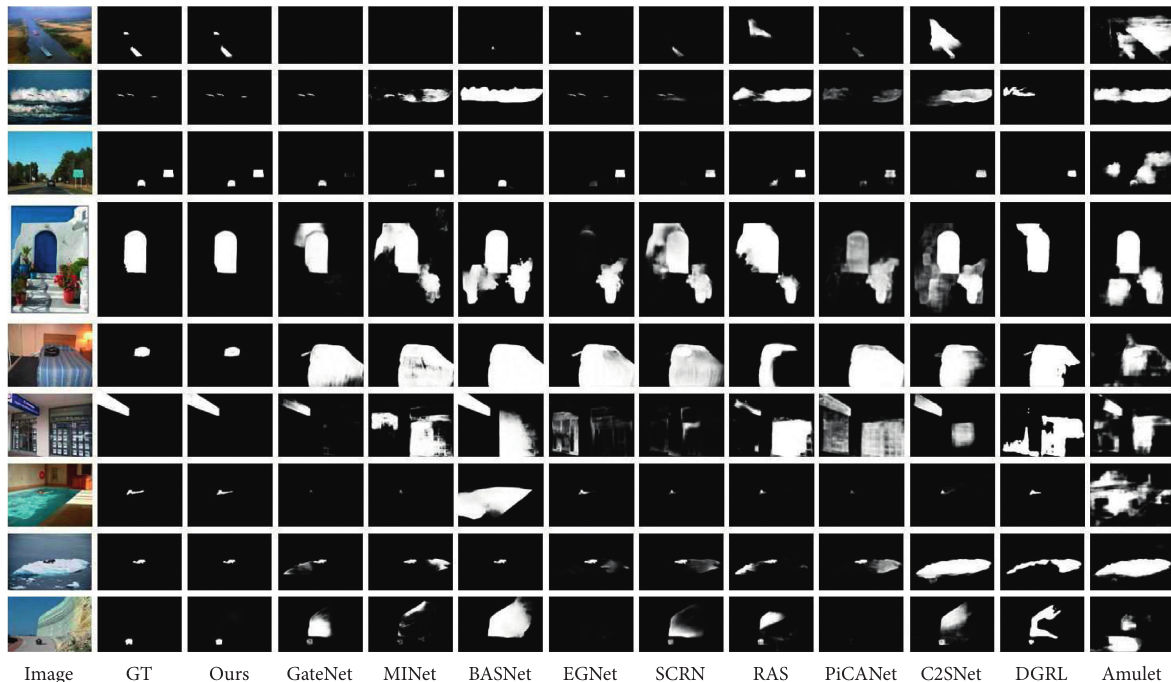
Figure 9: Visual comparison of our method with ten state-of-the-art